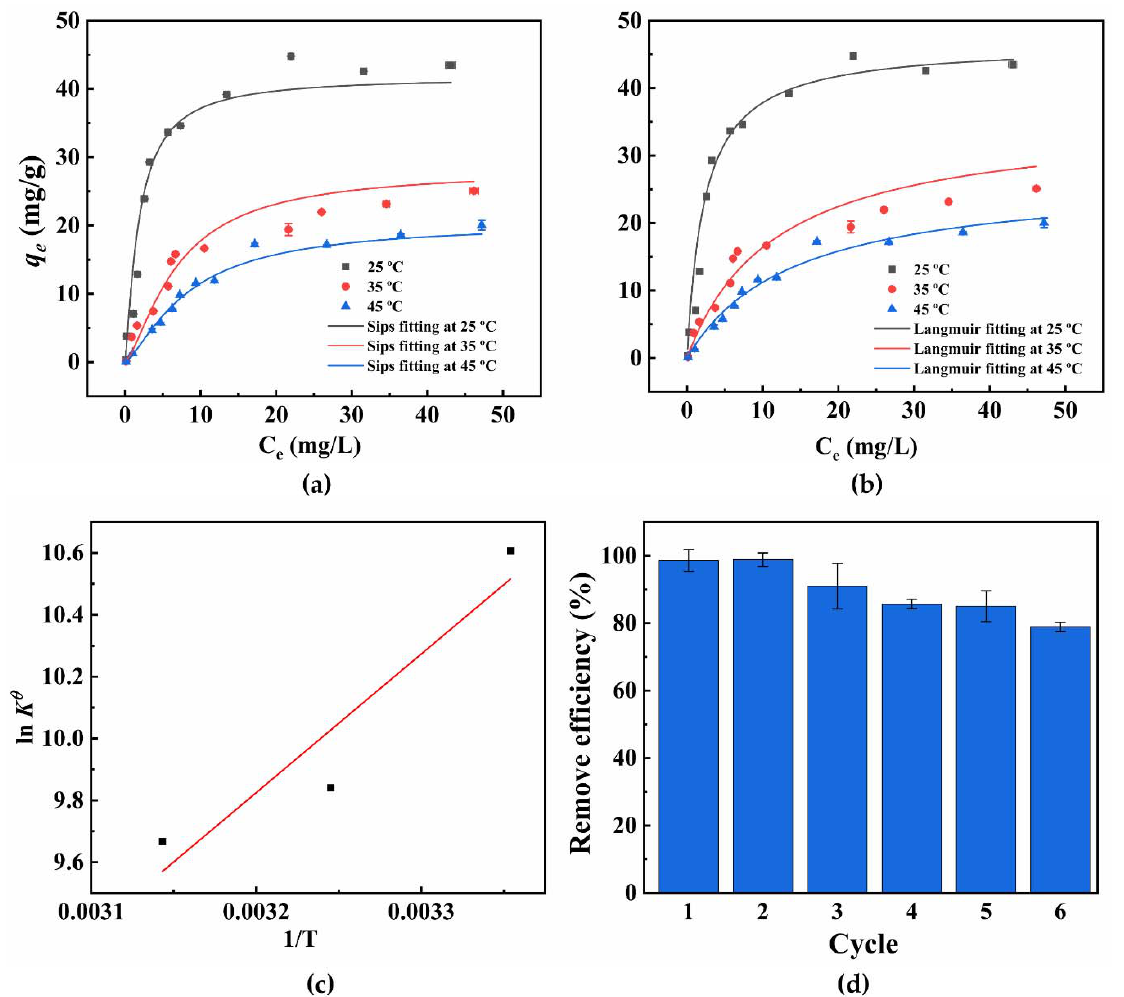
Figure 5. 4 − NP removal by Mg/Si 1:6 with Sips isothermal fitting ( a ). Langmuir isothermal fitting ( b ). Plot of ln K θ versus 1/T ( c ). Recycling of Mg/Si 1:6 in the adsorption of 4 − NP ( d ). Table 3. Adsorption isotherm parameters for the adsorption of 4 − NP.